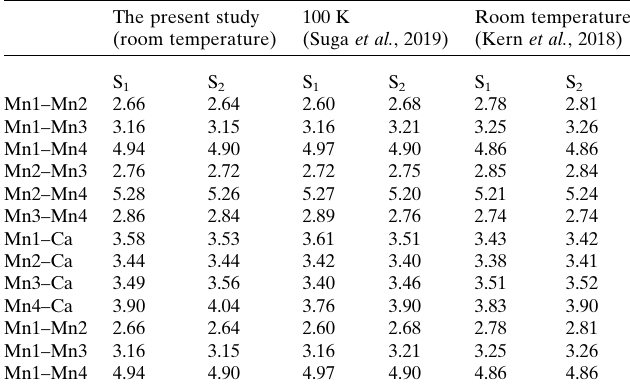
Table 2 Interatomic distances of the OEC and their comparisons between different structures. Values are averages of the nominal distances in two non-crystallographic symmetry related monomers. The present study 100 K (room temperature) (Suga et al. , 2019)